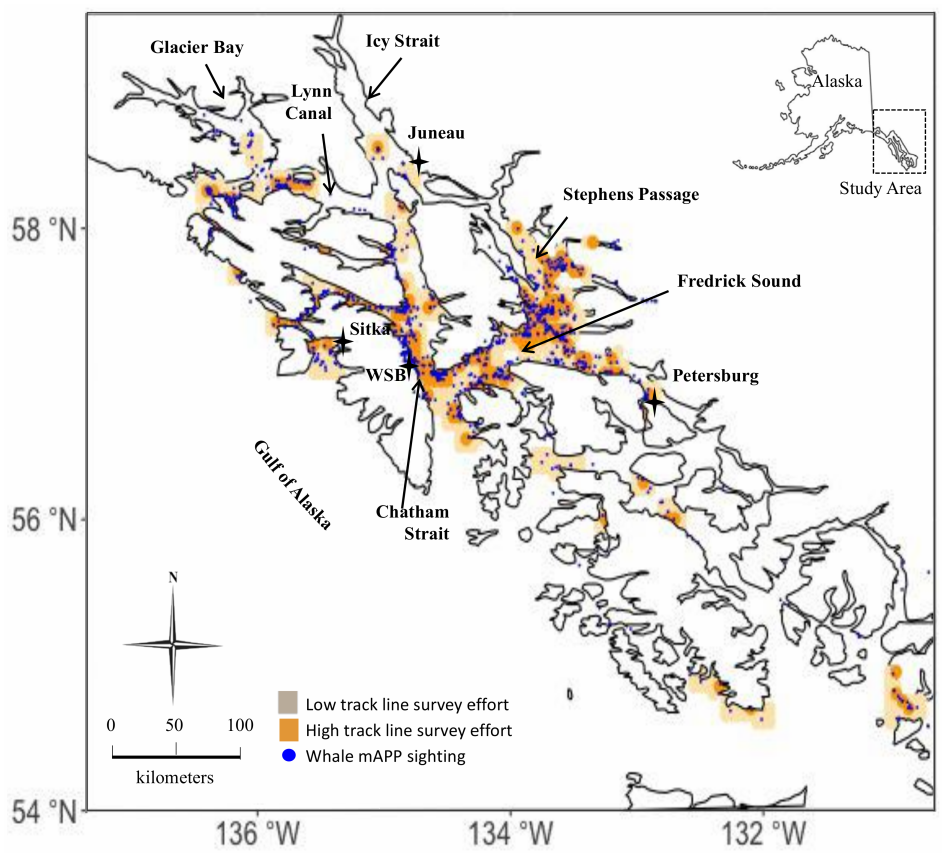
Figure 9. Map showing low and high track line survey effort and Whale mAPP-sighting